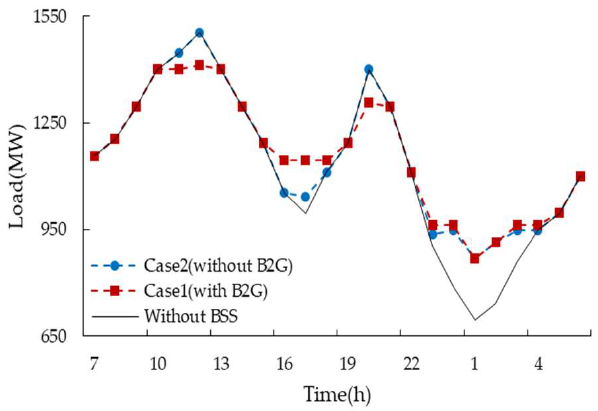
Figure 5. Total load curves formed in case 1 and case 2.